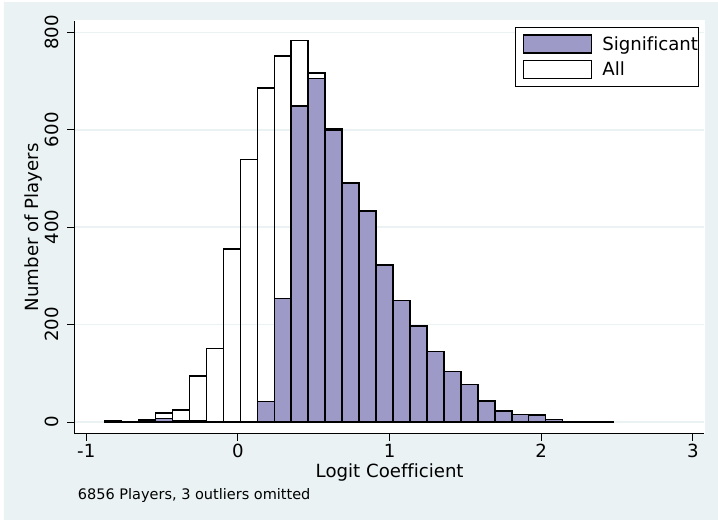
Figure 6. Coefficient in the k 1 multinomial logit. Note: The coefficient is β from the logit estimation, run separately for each player, U rock